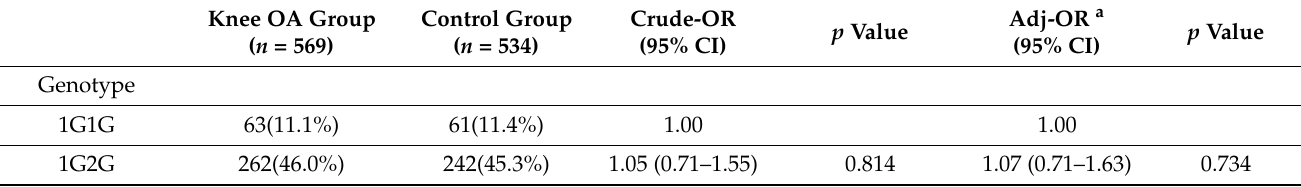
Table 2. Association between genetic polymorphism of MMP1 rs1799750 and knee OA. Knee OA